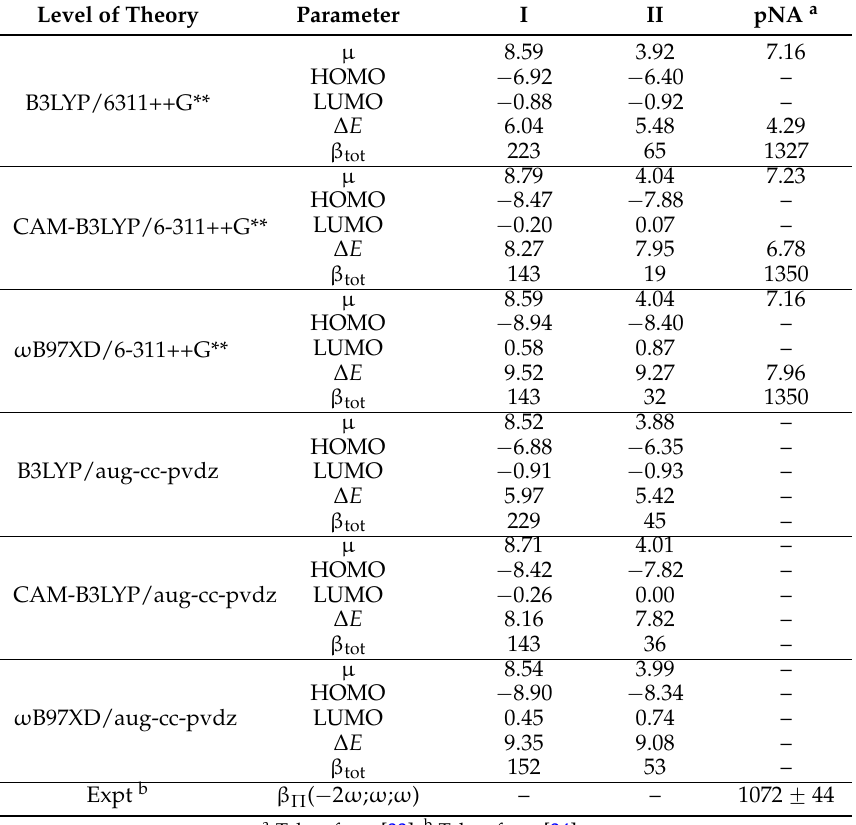
Table 9. Dipole moments ( µ /Debye), Highest Occupied Molecular Orbital (HOMO) and Lowest Unoccupied Molecular Orbital (LUMO) energies (eV) and their energy gaps (E.G. = ∆ E /eV), and total hyperpolarizability ( β tot /a.u.) for I and II which were computed using B3LYP, CAM-B3LYP, and ω B97XD functionals with 6-311++G** and aug-cc-pvdz basis sets. The data for p-nitroaniline (pNA) is given for comparison